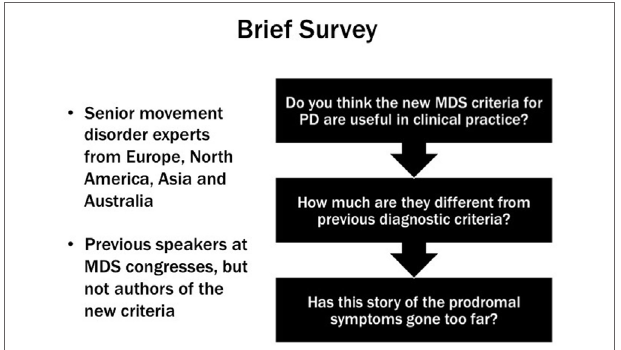
FiGURe 1 | Schematic representation of the three questions posed to the movement disorder experts during the brief